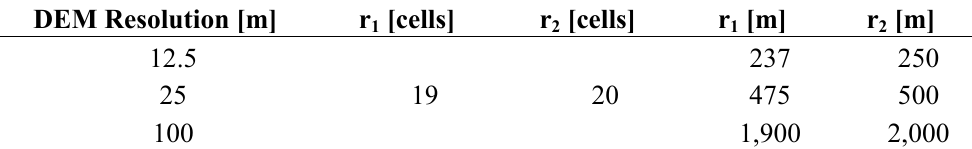
Table 5. Dimensions of annular-shaped moving window (AMW) according to different DEM resolutions.